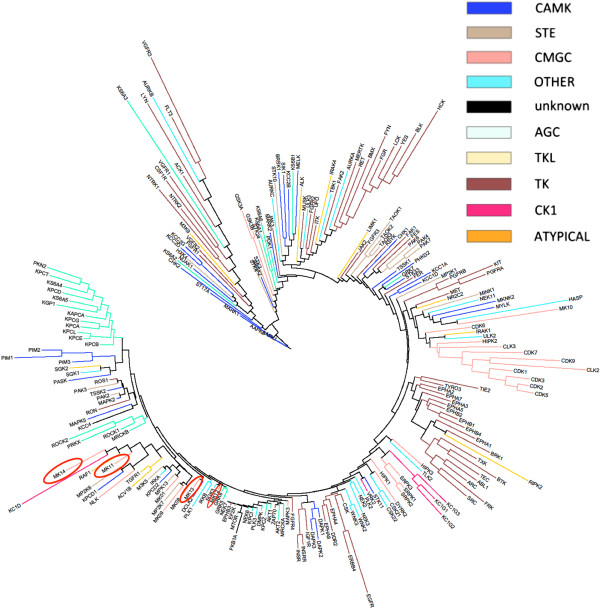
Kinome tree constructed with a distance matrix based on fingerprint enrichments. Kinases were colored based on the classification of kinase groups as defined by Manning et al.[5] Overall, kinases from the same group (with the same color) tend to group in the same cluster. CDK and CLK kinases from the CMGC group and AGC kinases are clearly grouped together. However, kinases from the same family or group do not always cluster together, as for example is the case with MK12 (p38γ) and MK13 (p38δ), which are both isolated from each other. On the other hand, the very similar proteins MK14 (p38α) and MK11 (p38β) are located close to each other.